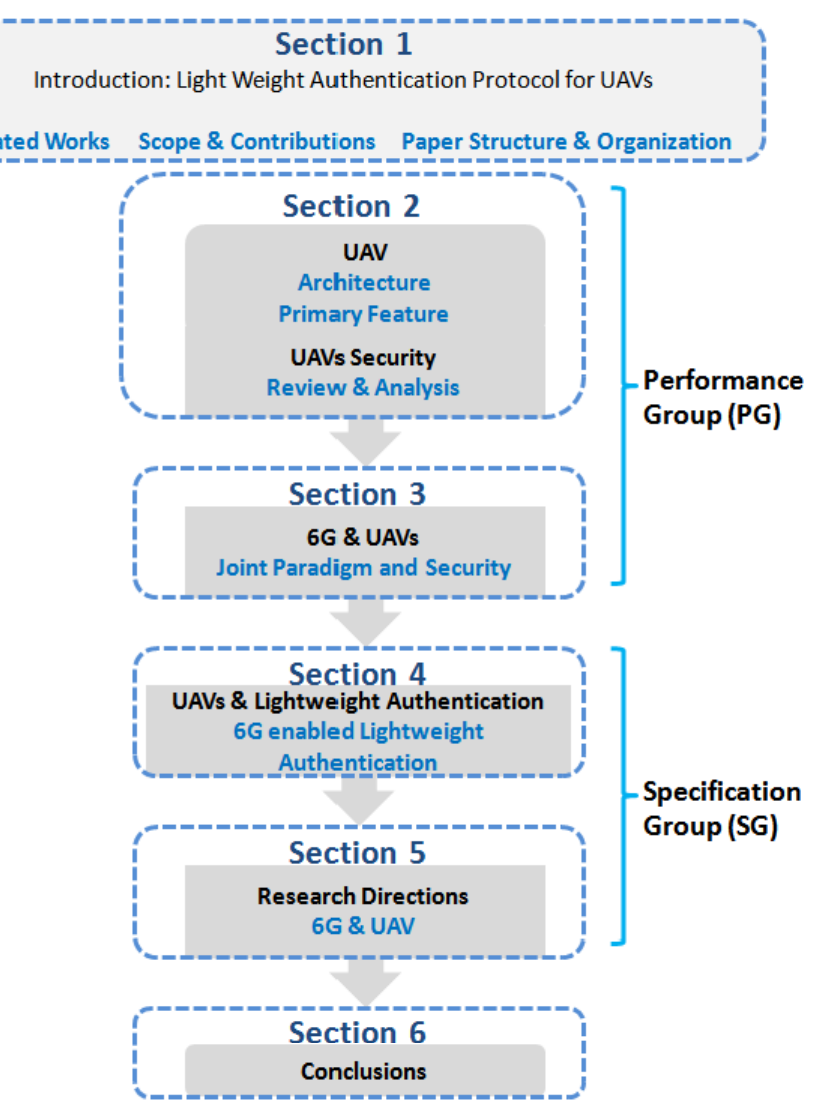
Figure 2. Structure and organization of this paper.